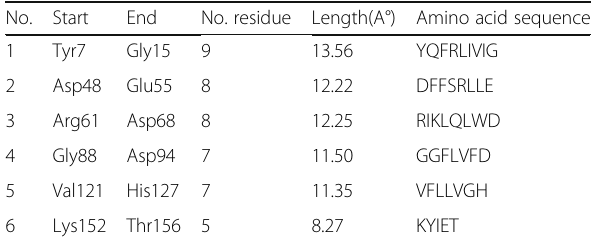
Table 3 Secondary structure details of the Rab39a: the β -sheets in